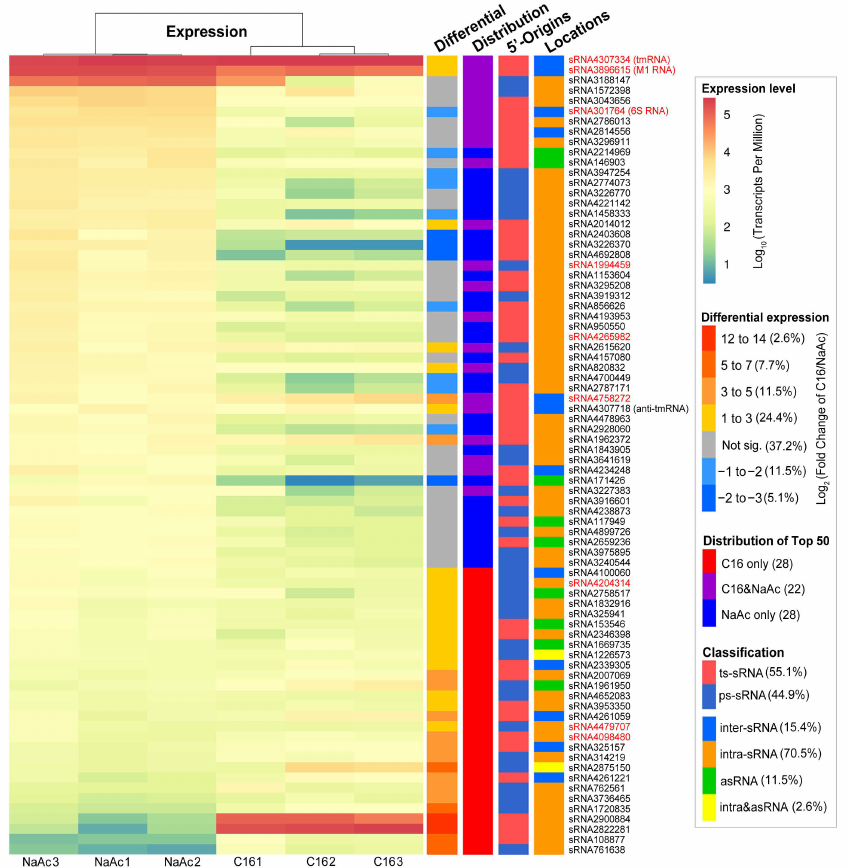
Figure 6. Expression of the top 50 sRNAs in alkane and non-alkane conditions. From left to right, the heatmap and colored bar charts show the expression levels in each sample of NaAc (non-alkane) or C16 (alkane) as carbon source, the differential expression of alkane vs. non-alkane conditions, the distribution of the top 50 highly expressed sRNAs in the two conditions and the classifications based on sRNA origins and locations. The sRNA names are listed behind, and the broadly conserved ones are in